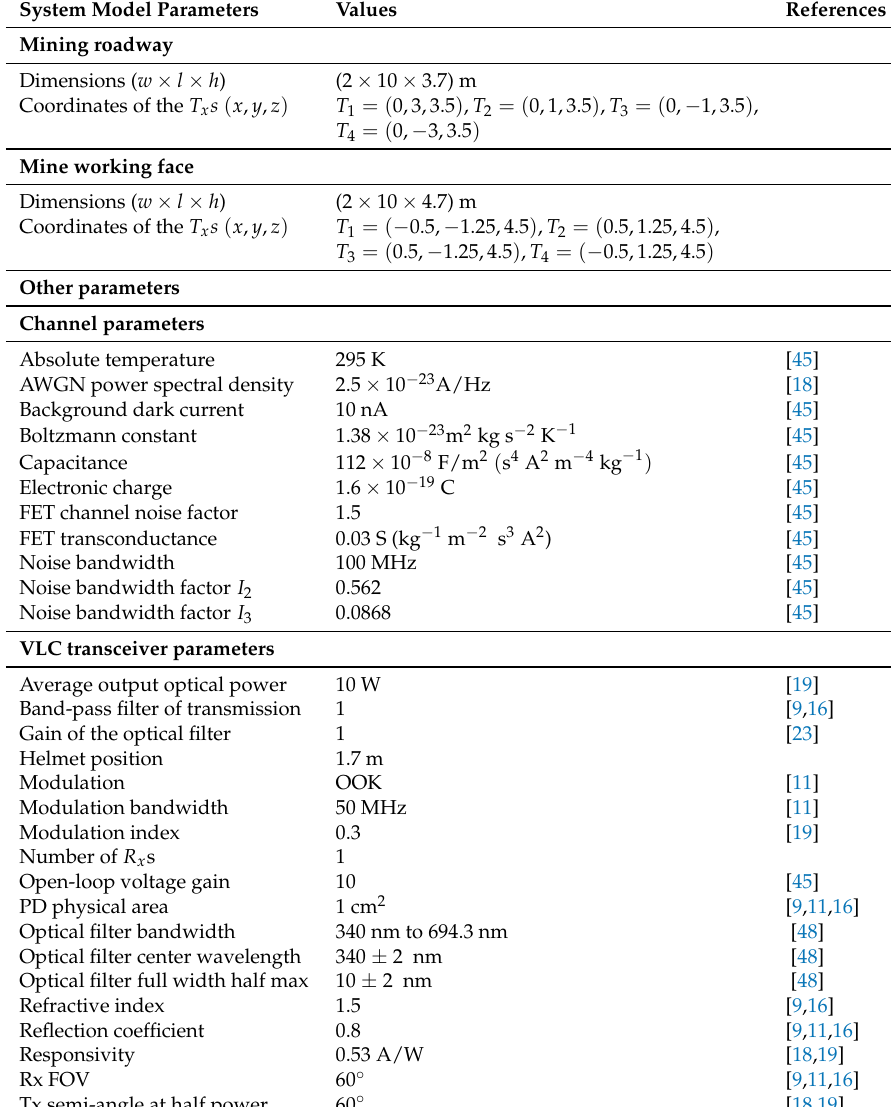
Table 1. Underground mining VLC system simulation